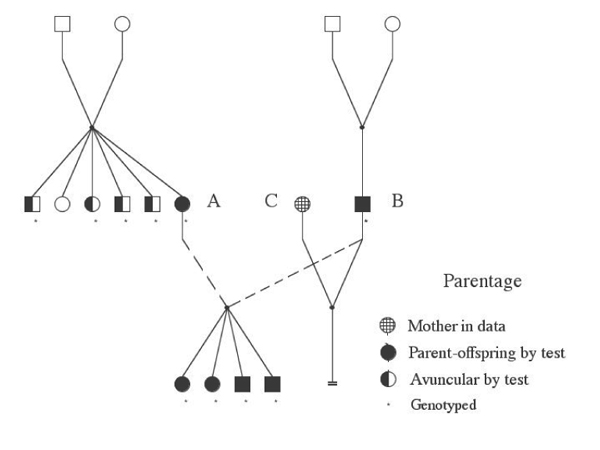
Pedigree error example 1 In the Framingham data the four offspring in the third generation were assigned mother C, but the tests identified A as the biological mother. B was confirmed as the biological father. The dashed lines indicate the corrected relationships.